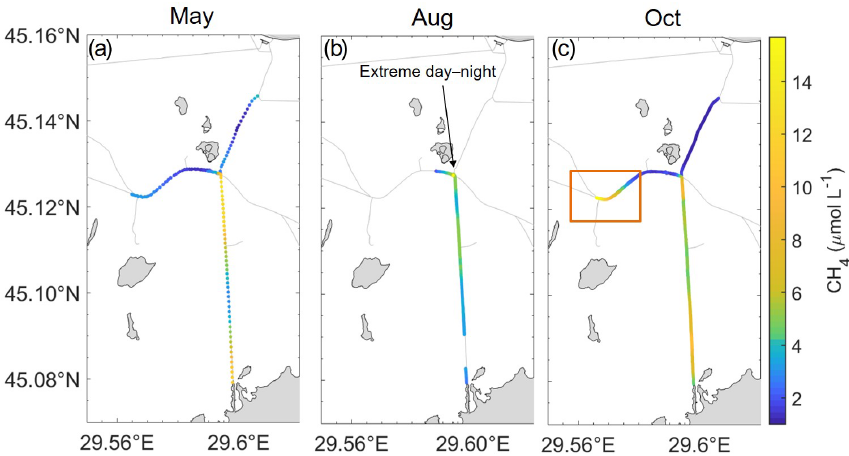
Figure 5. Spatial variability of CH 4 (µmolL − 1 ) in the hot spot location (red box), over the three campaigns (May, August and October). These waters were shown to have an overall influence on concentrations (a–c) , reaching a maximum of 15.68 (µmolL − 1